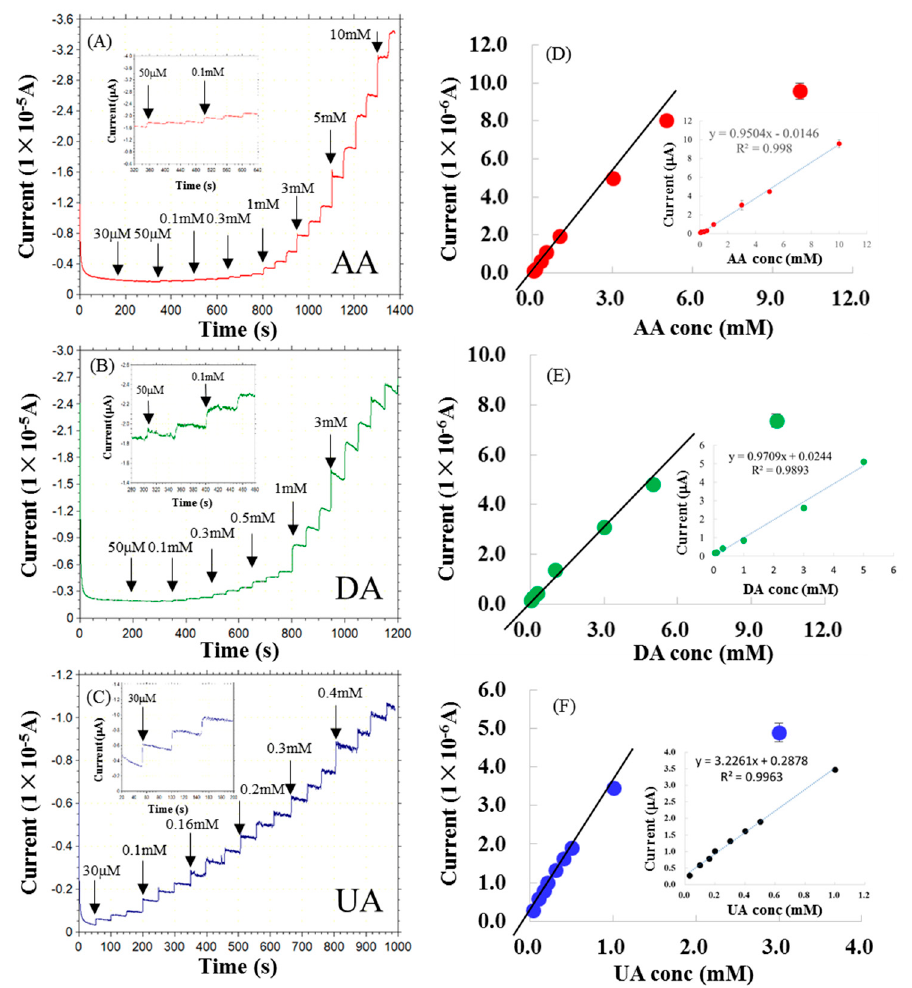
Figure 4. Steady-state amperometric responses of the CB-CNT/PI/GCE for the subsequent addition of ( A ) AA ( − 0.05 V), ( B ) DA (+0.2 V) ( C ) UA (+0.35 V) in a 0.1 M PBS (pH 7.0). The oxidation curves vs. the concentration of various substances: ( D ) AA, ( E ) DA, and ( F ) UA.